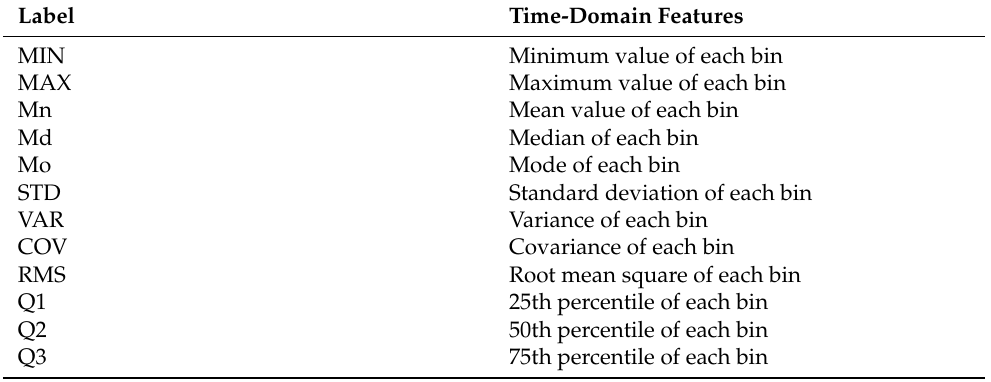
Table 1. List of time-domain features.